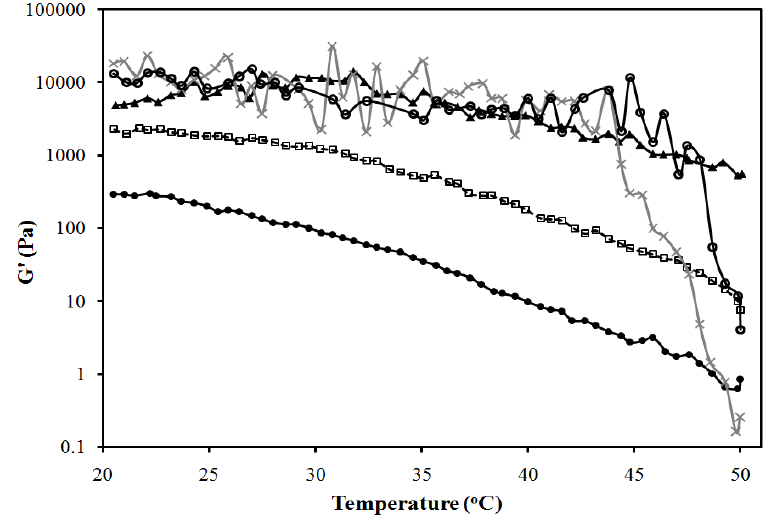
Figure 10. Elastic modulus vs. temperature profile for the systems of Figure 8b: ( ▲ ) 30% aqueous; ( ● ) 50% aqueous; ( □ ) 80% aqueous; (×) 90% aqueous. Control (20% gelatin in 0.9% NaCl solution) is shown as ( ○ ). A linear regression between log(G’) and T (from 25 to 40°C) was evaluated for gelatin, log(G’,Pa) = 4.7(±0.3) − 0.027(±0.009)T(°C), (R 2 = 0.27); for 30% water log(G’,Pa) = 4.78(±0.21) − 0.031 (±0.006)T(°C), (R 2 = 0.52); for 50% water log(G’,Pa) = 4.52(±0.07) − 0.087 (±0.002)T(°C), (R 2 = 0.98); for 80% water log(G’,Pa) = 5.24(±0.09) − 0.074 (±0.003)T(°C), (R 2 = 0.96); for 90% water log(G’,Pa) = 4.51(±0.37) − 0.019 (±0.011)T(°C), (R 2 = 0.104). The ±deviations in parentheses represent the standard deviation of the regression parameters (Excel 2010 data analysis